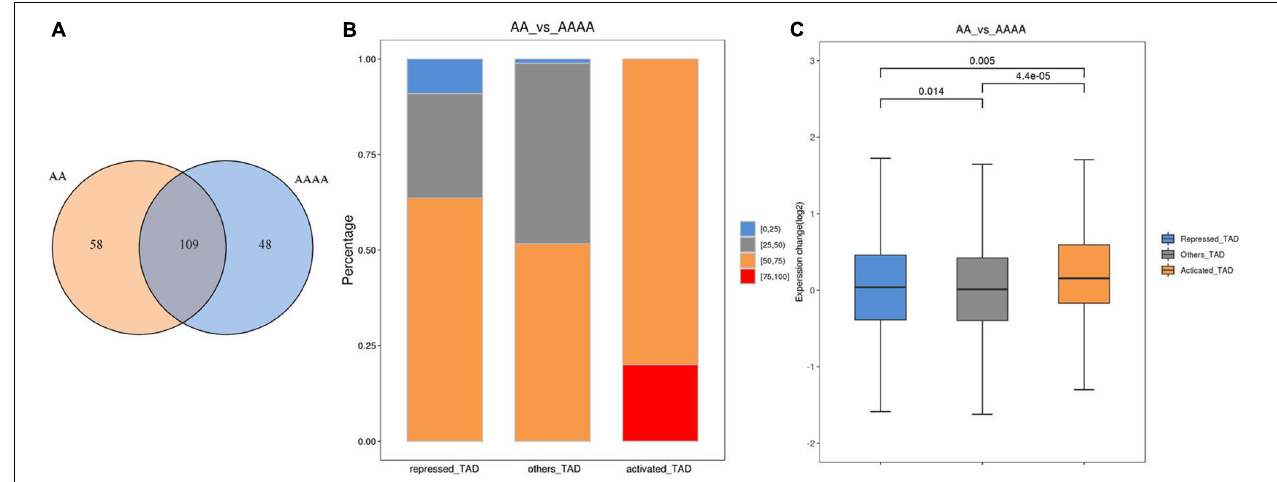
FIGURE 4 | The analysis of TADs in diploid and autotetraploid pak choi. (A) Venn diagram of TADs detected in AA and AAAA. (B) Proportional stacking maps of genes with different expression levels in different TADs. For each gene contained in the TADs, the change in expression level was calculated for both sets of samples, and the percentage of all genes corresponding to that TAD with Fold Change greater than 1. The percentages were divided into four categories, including 0–25%, 25–50%, 50–75%, and 75–100%. The results for the different categories of TADs were presented in the form of bar charts. (C) Gene expression of the three types of